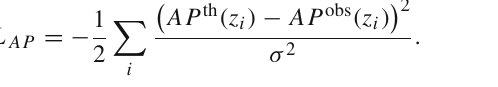
t is a reparametriza- b + d 2